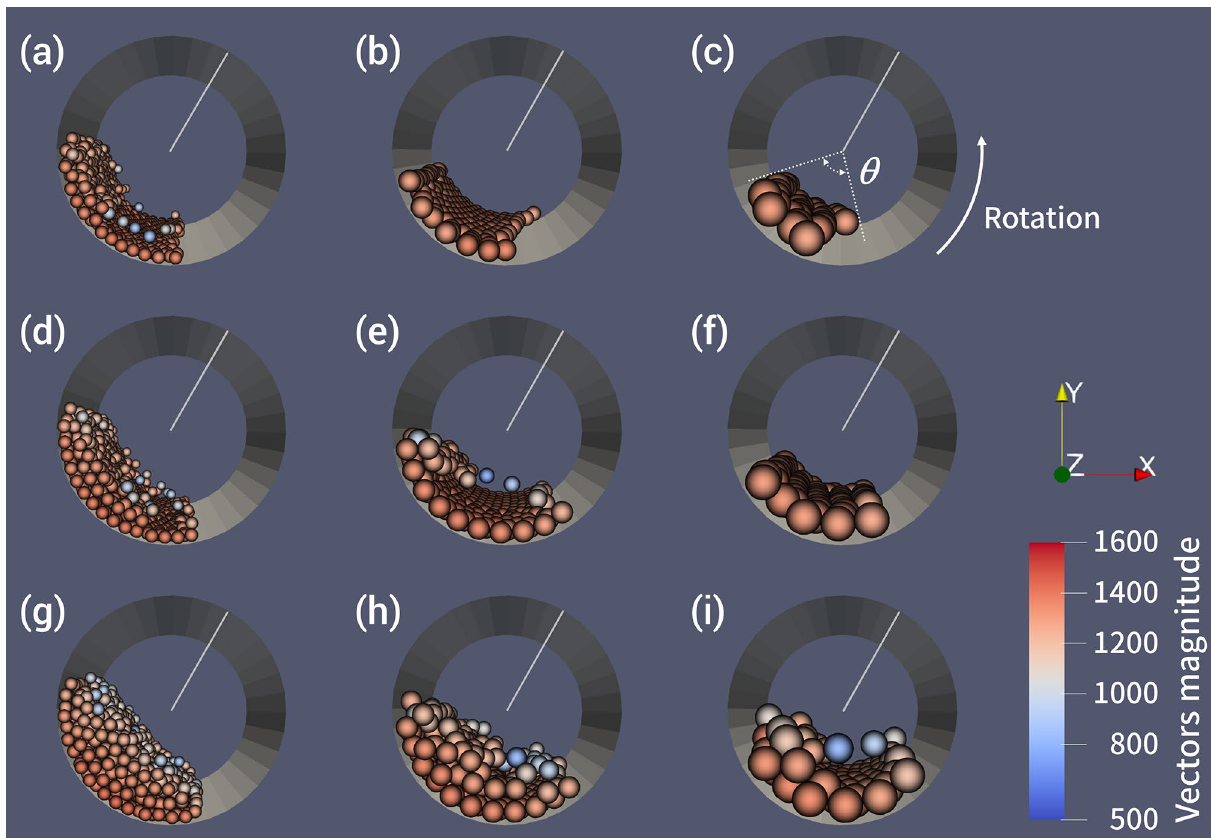
Figure 3. Snapshots of ball motion during the wet planetary ball milling at 150 G. Left column, 5 mm; right, 8 mm. Ball input: ( a – c ) 50 g, ( d – f ) 80 g, and ( g – i ) 140 g. The line from the center of the vessel indicates the direction of the center of revolution. Water is omitted from the visualization. Visualization of the ϕ ϕ simulated data was performed using ParaView software (ver. 5.8.0).